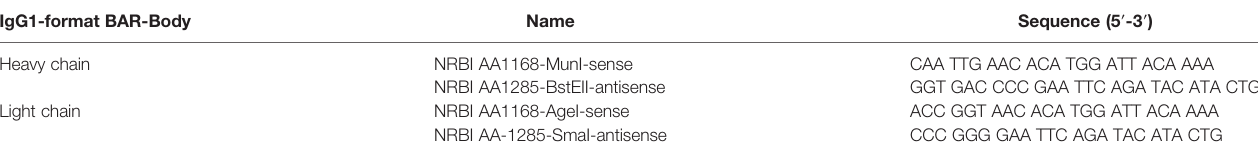
TABLE 2 | Primers used for the IgG1-format neurabin-I